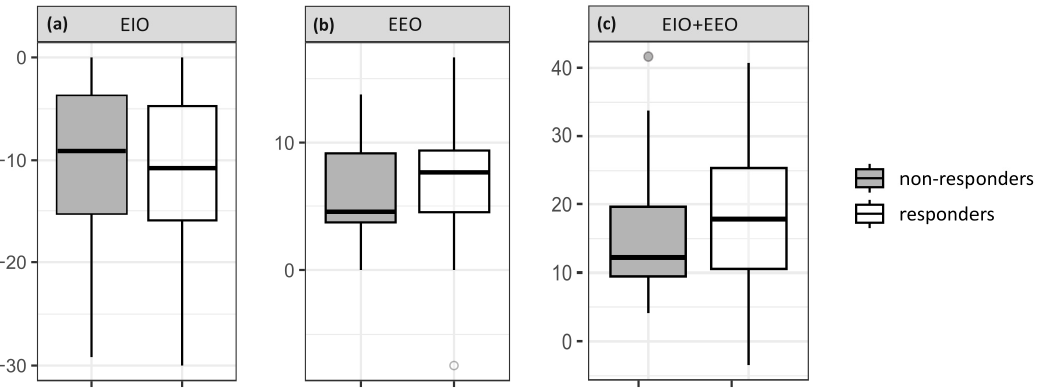
Figure 2. Boxplots displaying the changes in CI for ( a ) EIO, ( b ) EEO and ( c ) combined EIO + EEO. Table 3. Changes in hemodynamic parameters after respiratory occlusion tests and volume expan- sion.